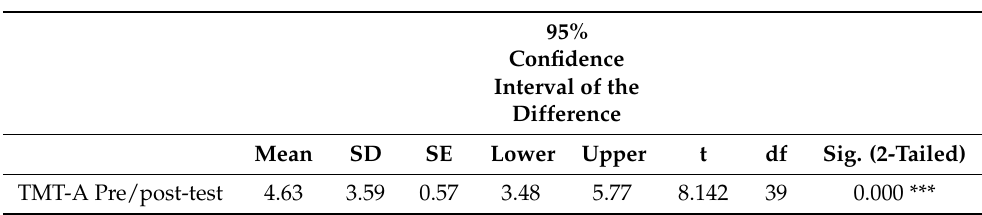
Table 15. Paired sample test of TMT-A.